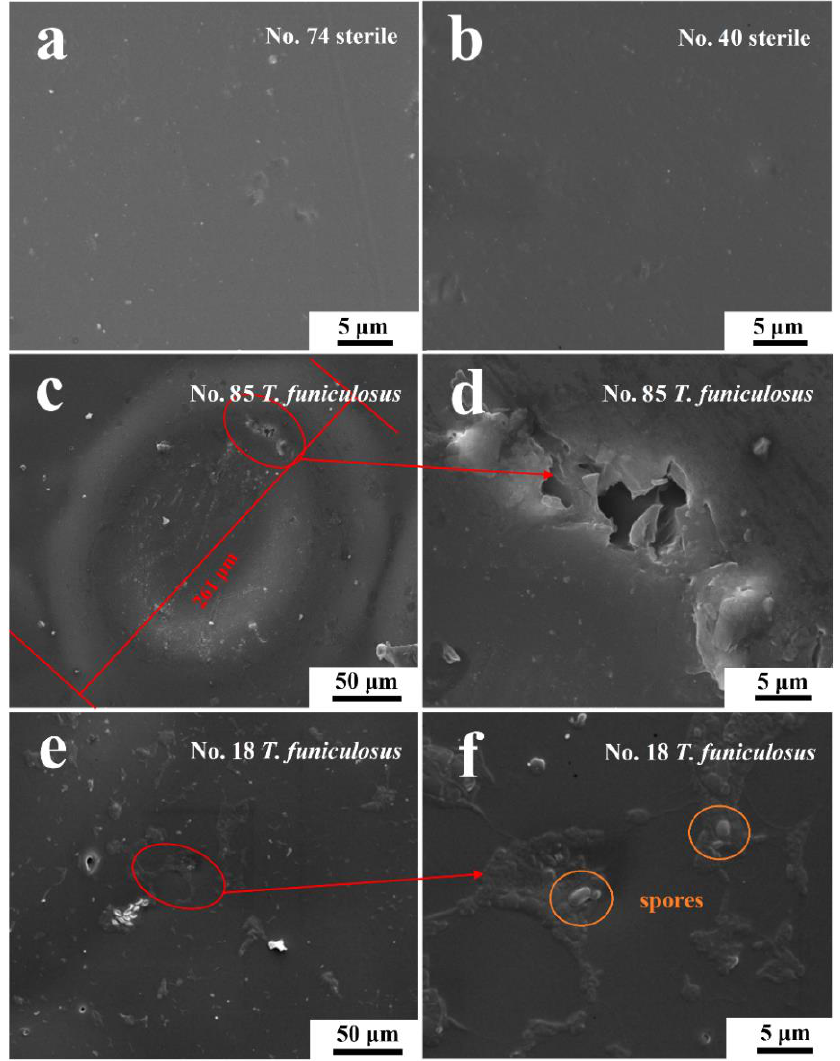
Figure 11. The SEM images of the #74 ( a ) and #40 electrode surfaces ( b ) after the immersion in sterile liquid mediums for 14 days and of the #85 ( c,d ) and #18 electrode surfaces ( e,f ) after the immersion in fungal liquid mediums for 14 days.